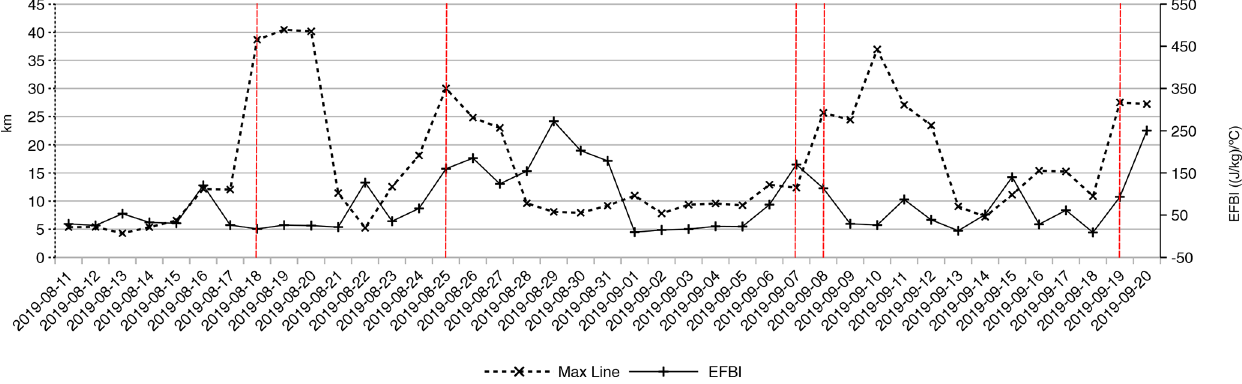
Figure 10. Maximum longitude of the daily burnt area and the EFBI and its components for the wildfire in Roboré, Bolivia, in 2019. Vertical dashed red lines show when a pyroCb took place. Please note that the date format in this figure is